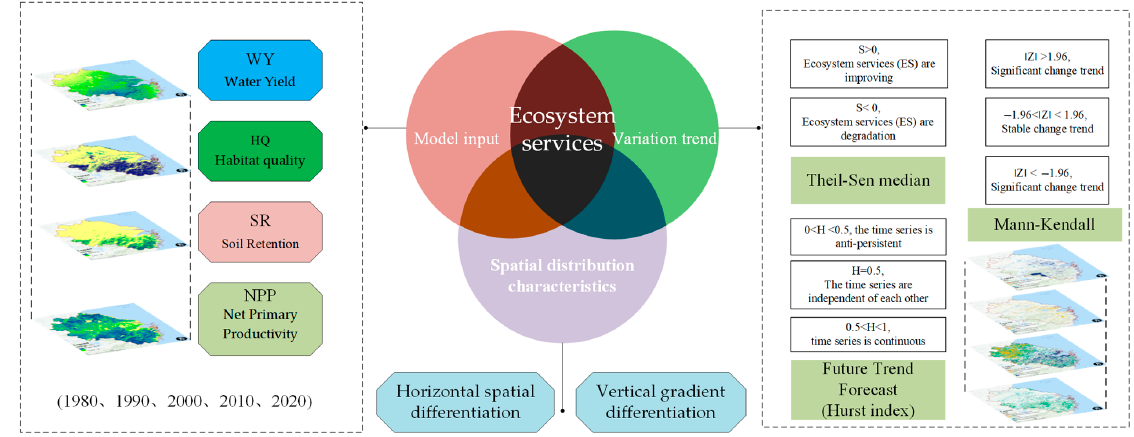
Figure 2. Research technical